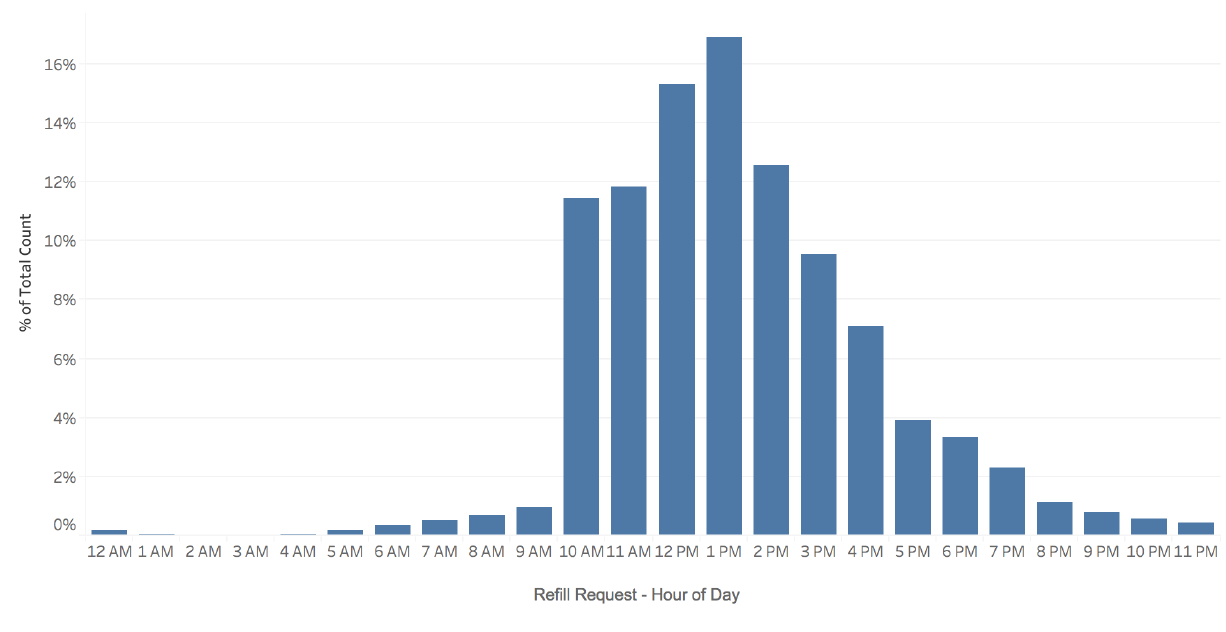
Figure 4. Percentage of refills requests by time of day.